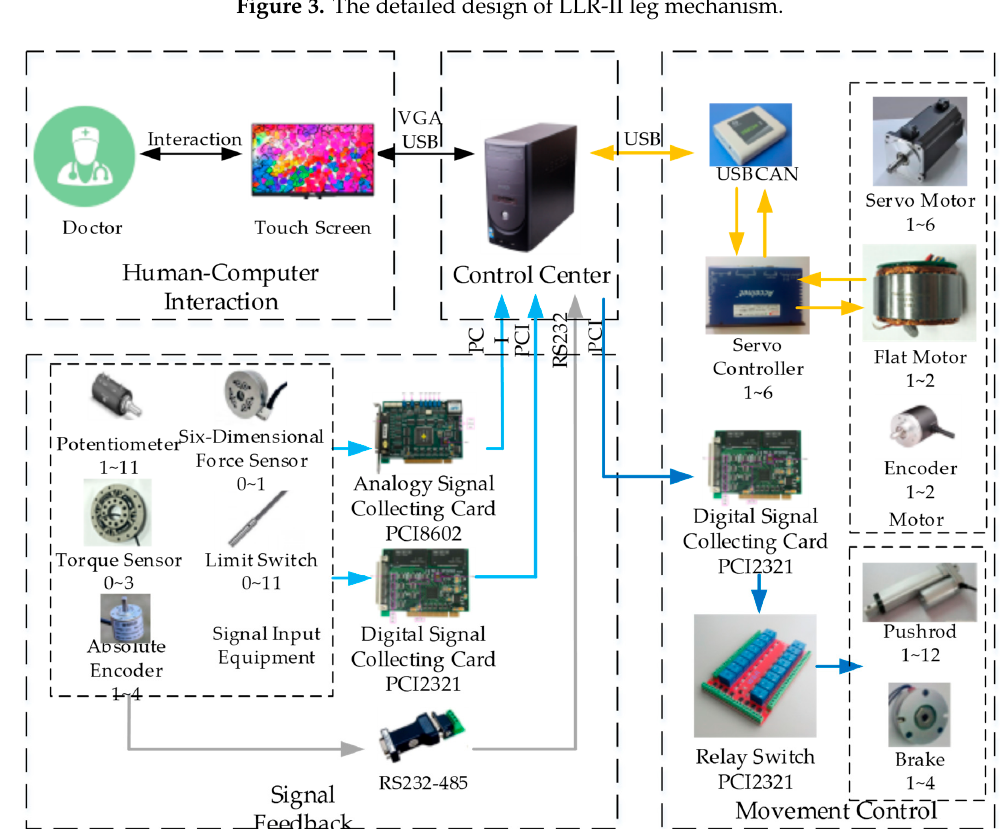
Figure 4. The sensors system composition of LLR-II.